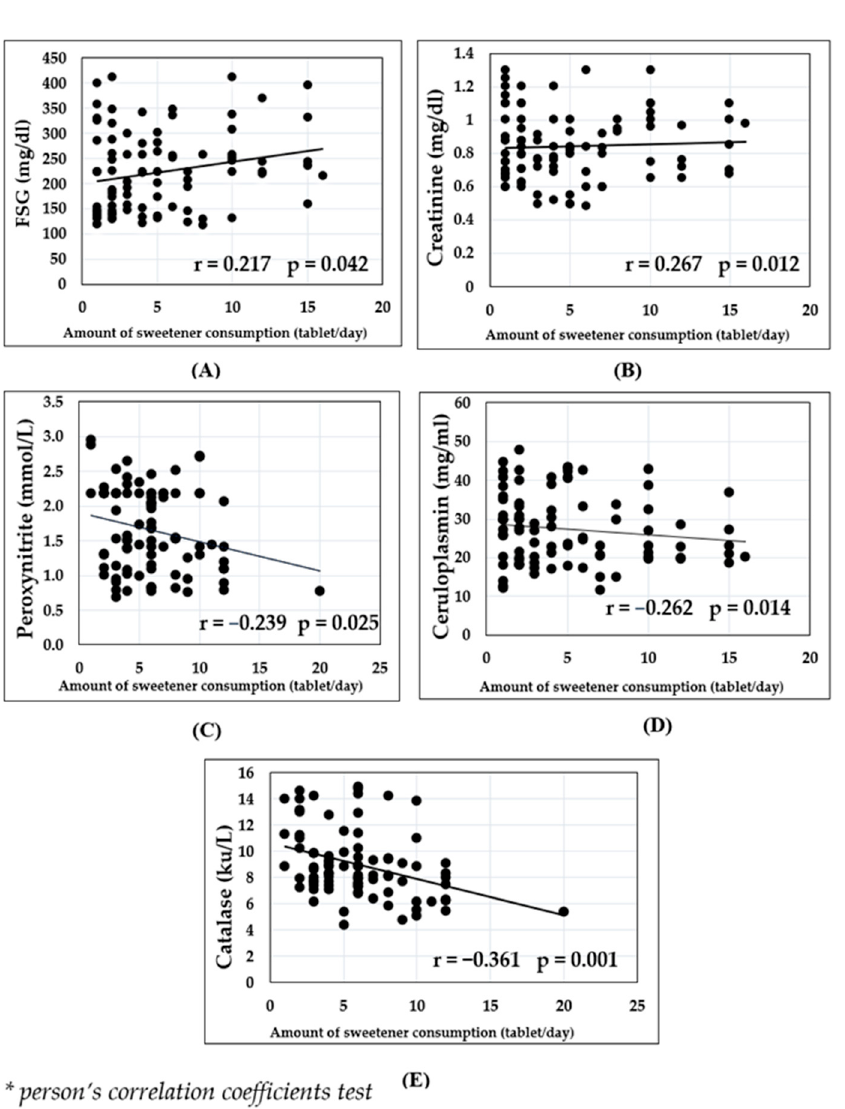
Figure 5. Pearson Correlation Coefficient (r) was calculated to analyze if there was a linear correla- tion between daily sweetener consumption and the concentration of the following parameters in diabetic patients: fasting blood glucose ( A ), creatinine ( B ), peroxynitrite ( C ), serum ceruloplasmin ( D ) and activity of serum catalase ( E ).